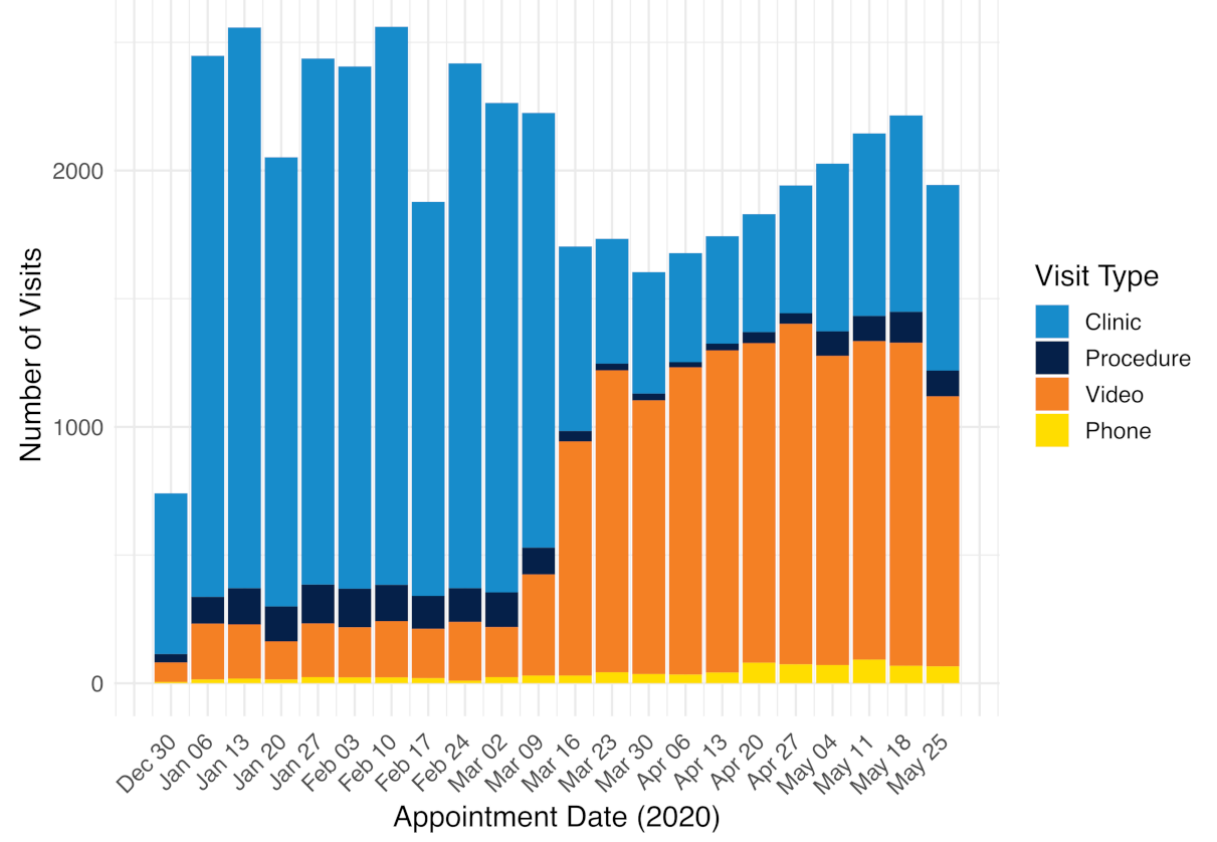
Figure 2. Number of clinic encounters stratified by visit type (in-person visits, procedural visits, video visits, and phone visits) from January 1 to May 31, 2020, with March 16, 2020, denoting the institution-wide transition to video visits in response to coronavirus disease